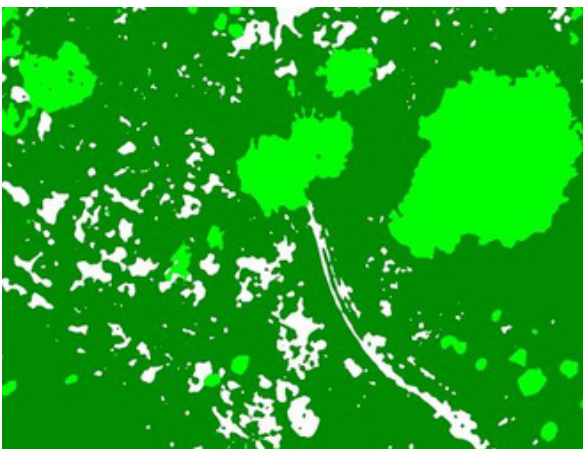
Figure 7: An example of automatic landcover classification (MLE).